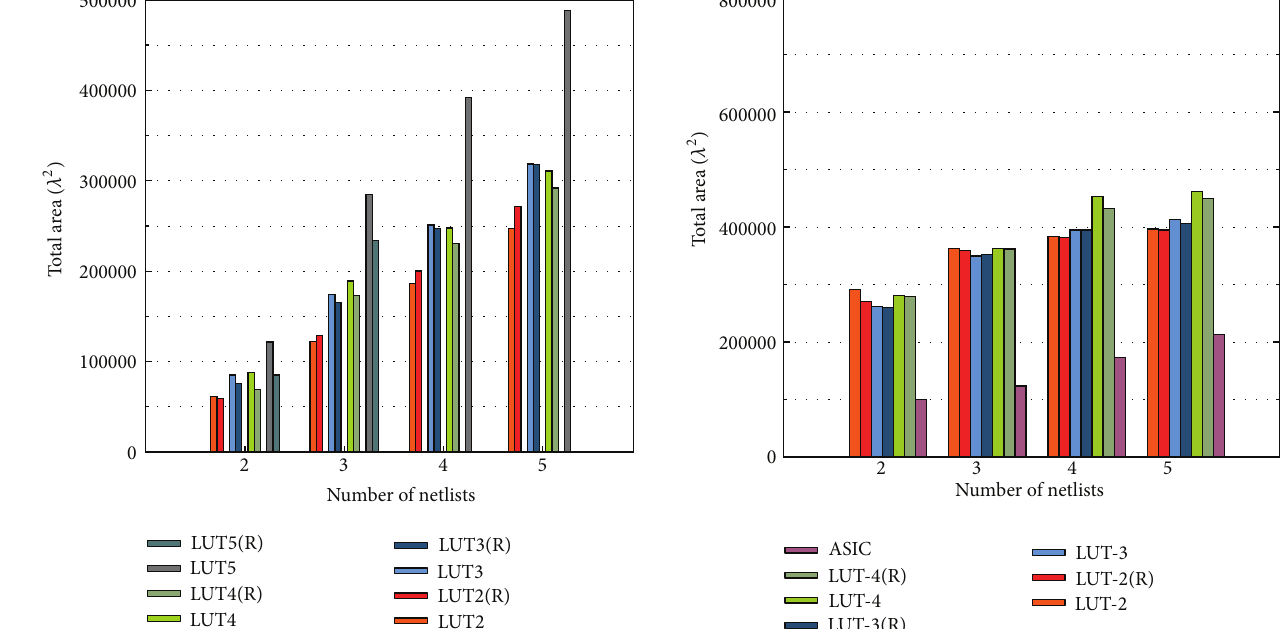
Figure 24: Total area comparison for OpenCores benchmarks [20]